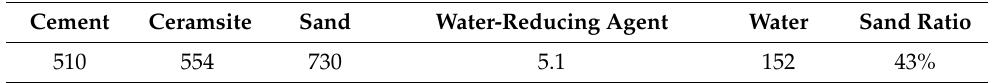
Table 5. Mixed proportion of ceramsite concrete beam specimens (unit: kg/m 3 ).